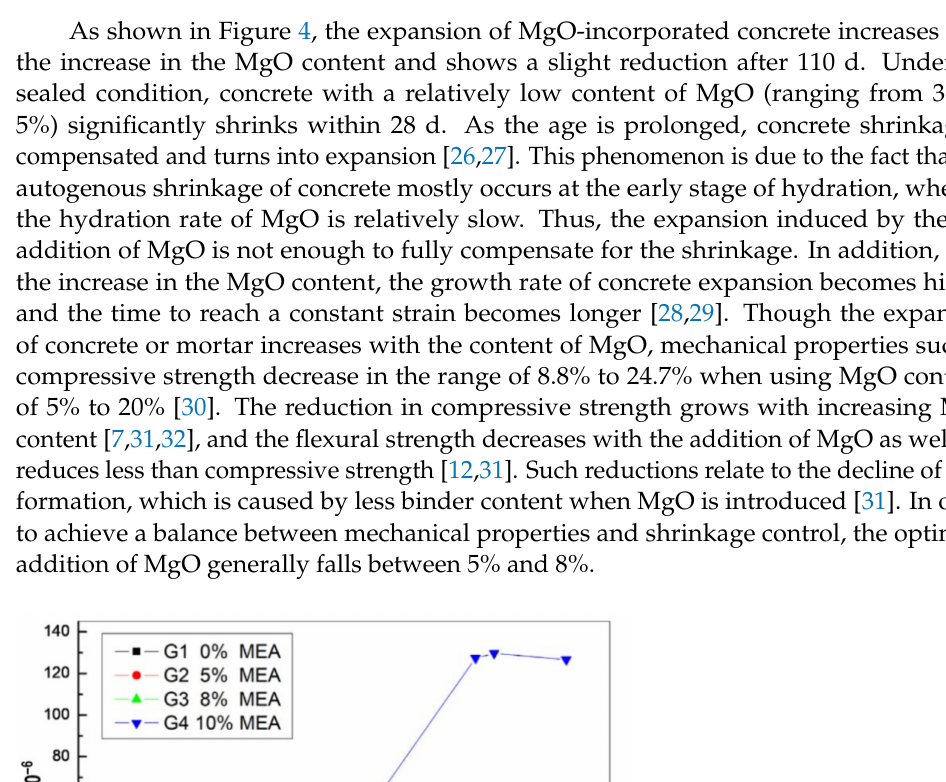
Figure 3. The development of periclase content during the hydration of cement paste with MgO characterized by QXRD (reaction times: R-60s, M-120s, and S-220s) (reprinted with permission from Ref. [23], 2019, Elsevier).